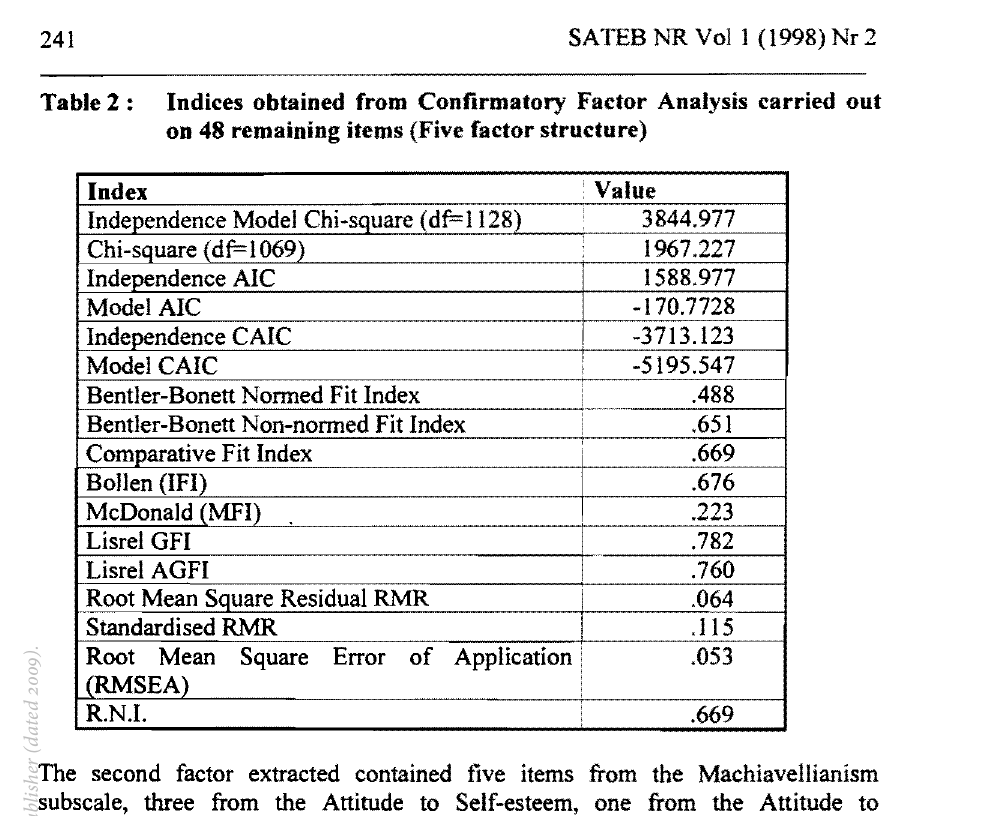
Table 2 : Indices obtained from Confirmatory Factor Analysis carried out on 48 remaining items (Five factor